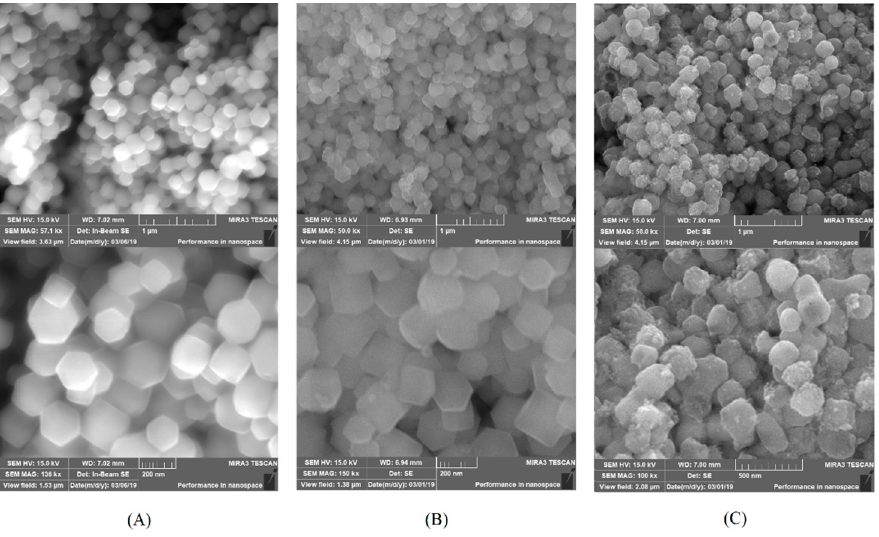
Figure 2. SEM of ZIF-67 ( A ), ZIF-67@EIM-Cl ( B ) and ZIF-67@EIM-MIM ( C ) with different scales.